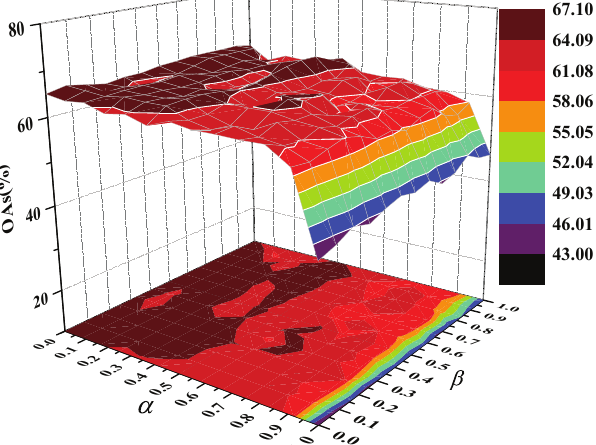
Figure 6. The OAs of SSRHE with different α and β on Indian Pines